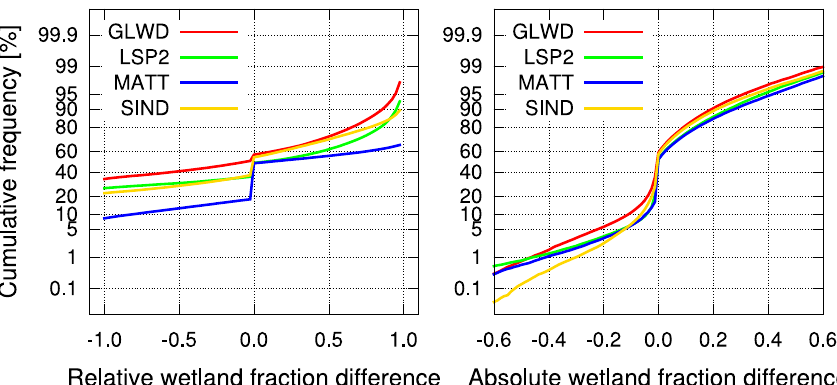
Fig. 9. Cumulative distributions of relative (left) and absolute (right) wetland extent difference at grid cell scale between the MPI-HM simulation and